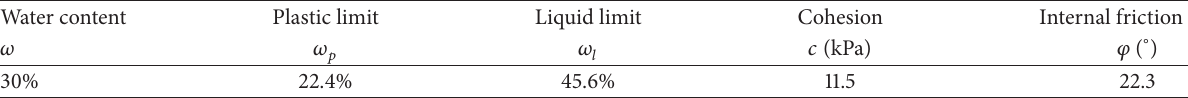
Table 1: Main properties of clay.